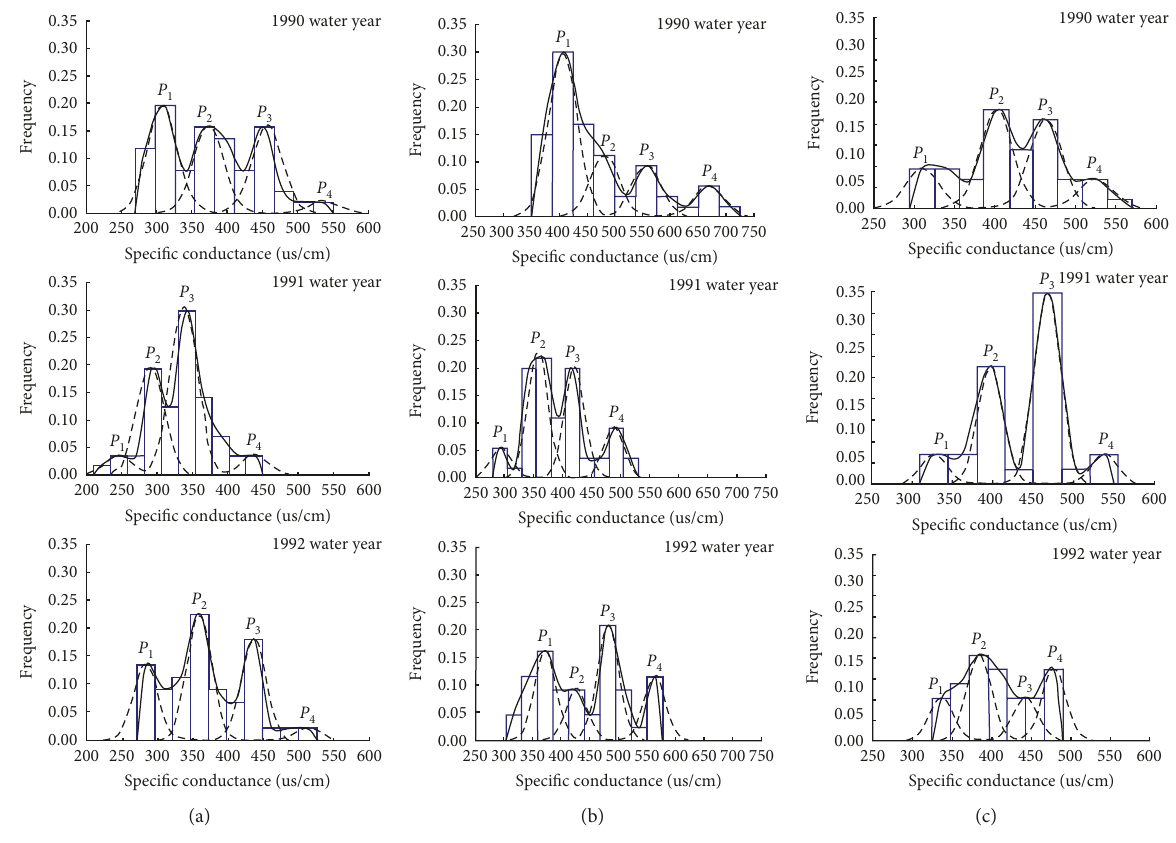
Figure 5: Specific frequency distribution curves of three stations in different water year. (a) Muzhudong station. (b) Laoheitan station. (c) Zilaishuijing station.